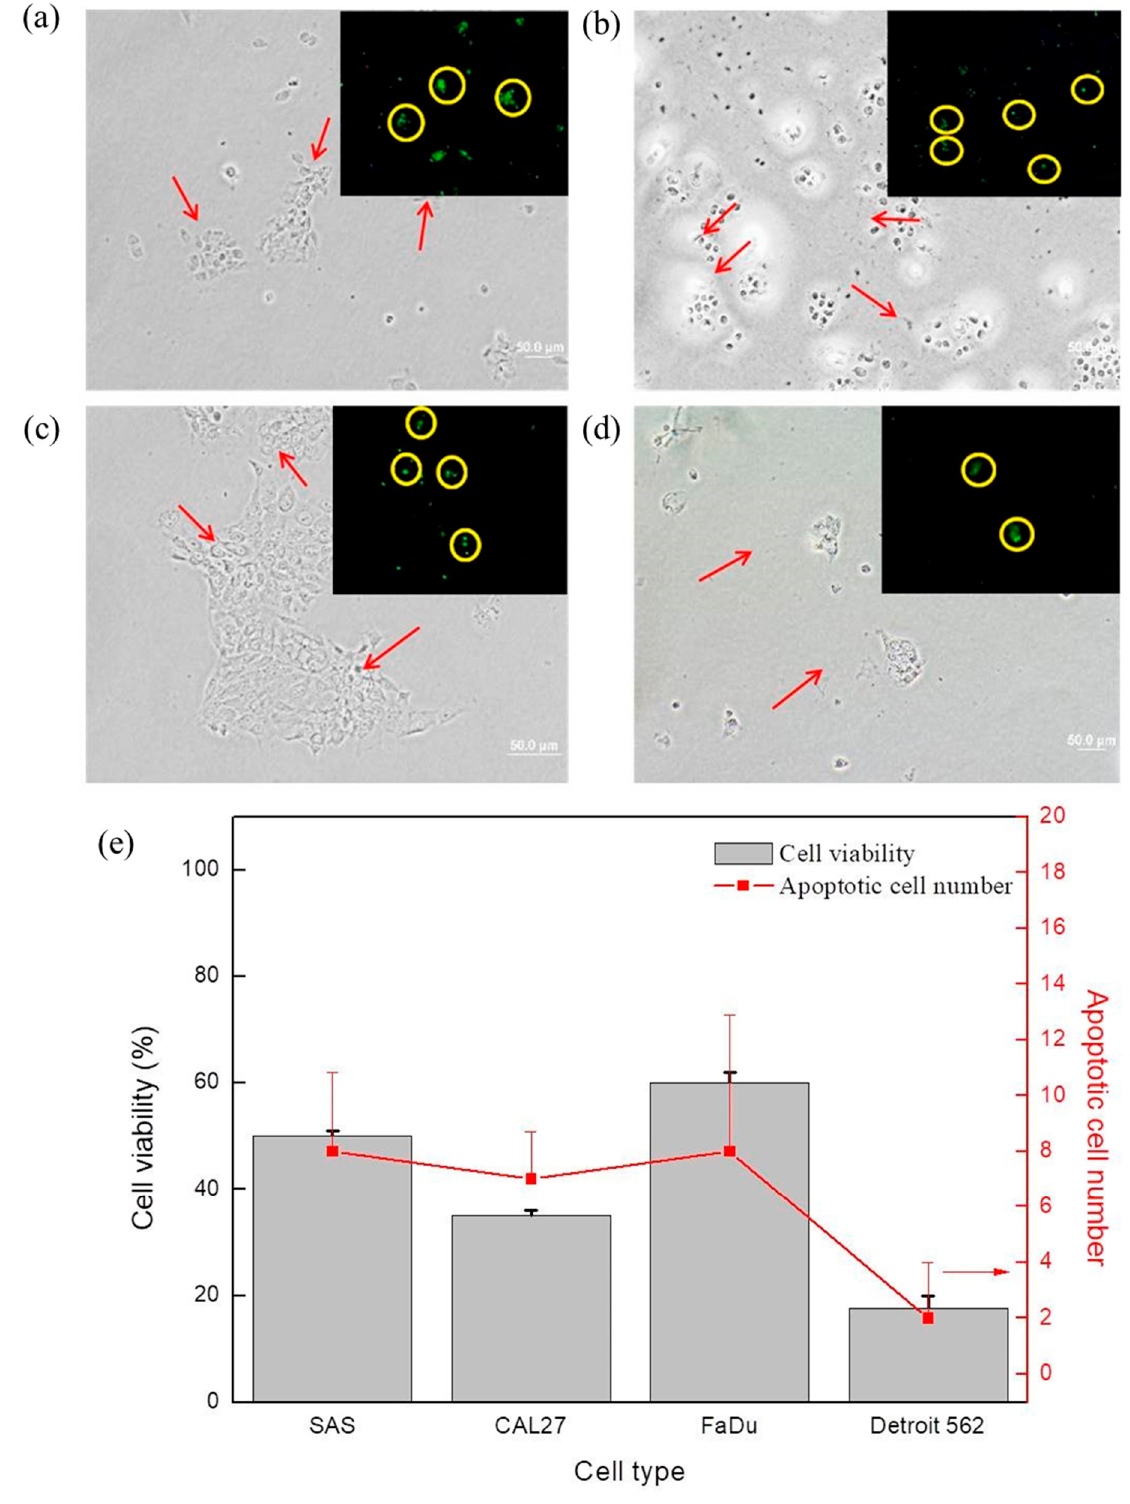
Figure 5. By using the TUNEL assay, the bright field images and fluorescence images (inset) of ( a ) SAS, ( b ) CAL 27, ( c ) FaDu, and ( d ) Detroit 562 cancer cells after N 2 /He plasma exposure of 90 s, and then cultured for 48 h are shown. The arrows show nuclear condensation and DNA fragmentation. ( e ) MTS assay and apoptotic cell number measured after N 2 /He plasma exposure of 90 s, and then cultured for 48 h.